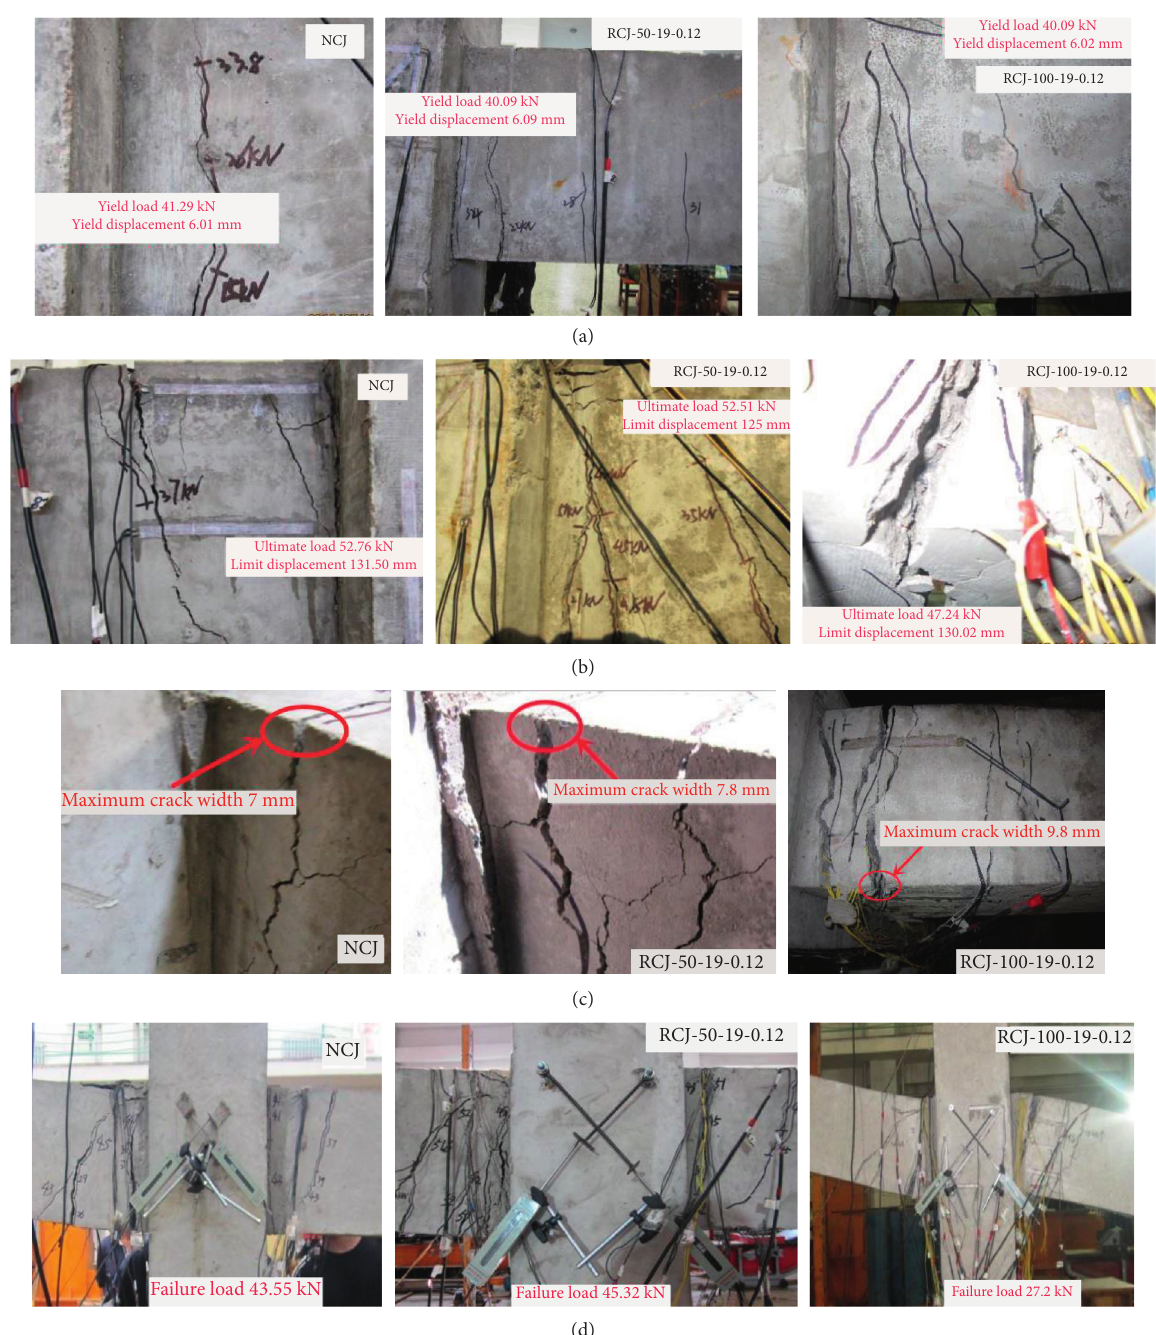
Figure 7: Experimental phenomena. (a) Yielding stage. (b) Ultimate stage. (c) Maximum crack width of beam end. (d) Joint form under failure